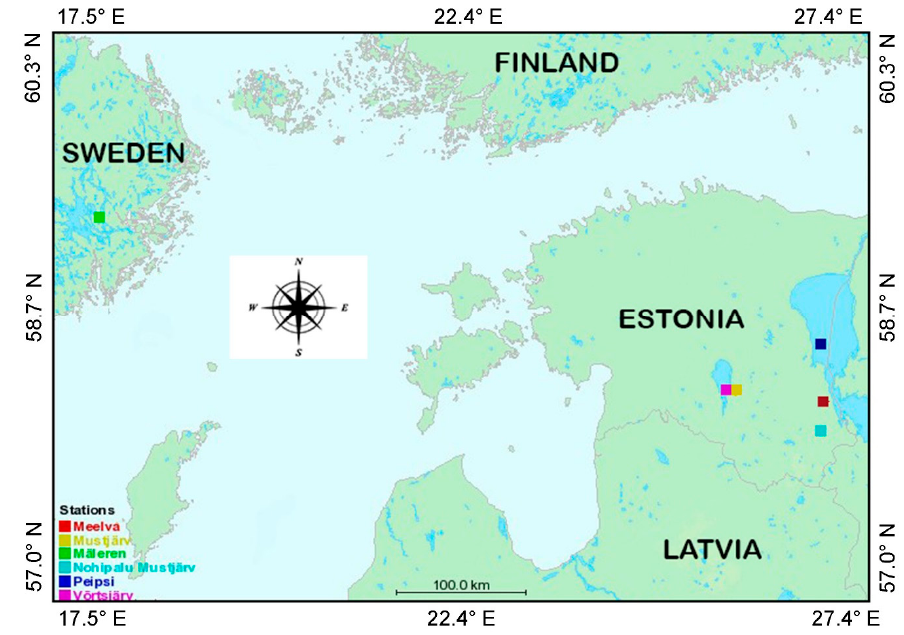
Figure 1. Locations of the study sites (GPS Visualizer).